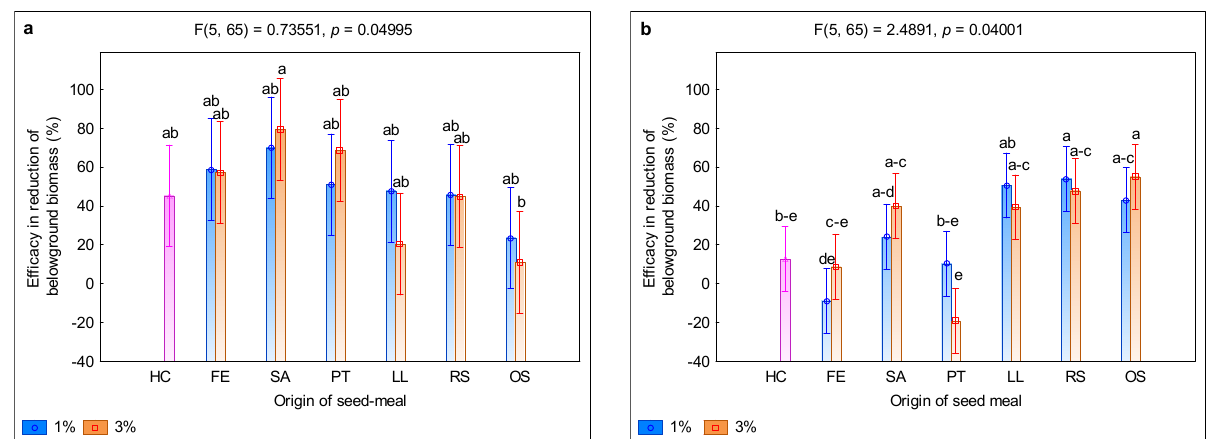
Figure 3. The mean efficacy in reduction in belowground biomass of herbicide-susceptible ( a ) and -resistant ( b ) biotypes of wild oat depending on the origin of seed meals and their concentration. Means with various letters are significantly different, according to Tukey test ( p ≤ 0.05). Vertical bars mean 0.95 confidence intervals. The symbols mean HC—herbicide control, and seed meals from FE— Fagophyrum esculentum , SA— Sinapis alba , PT— Phacelia tanacetifolia , LL— Lupinus luteus , RS— Raphanus sativus , OS— Ornithopus sativus . The column colors mean pink—herbicide control, blue—1% concentration of seed meals, orange—3% concentration of seed meals.